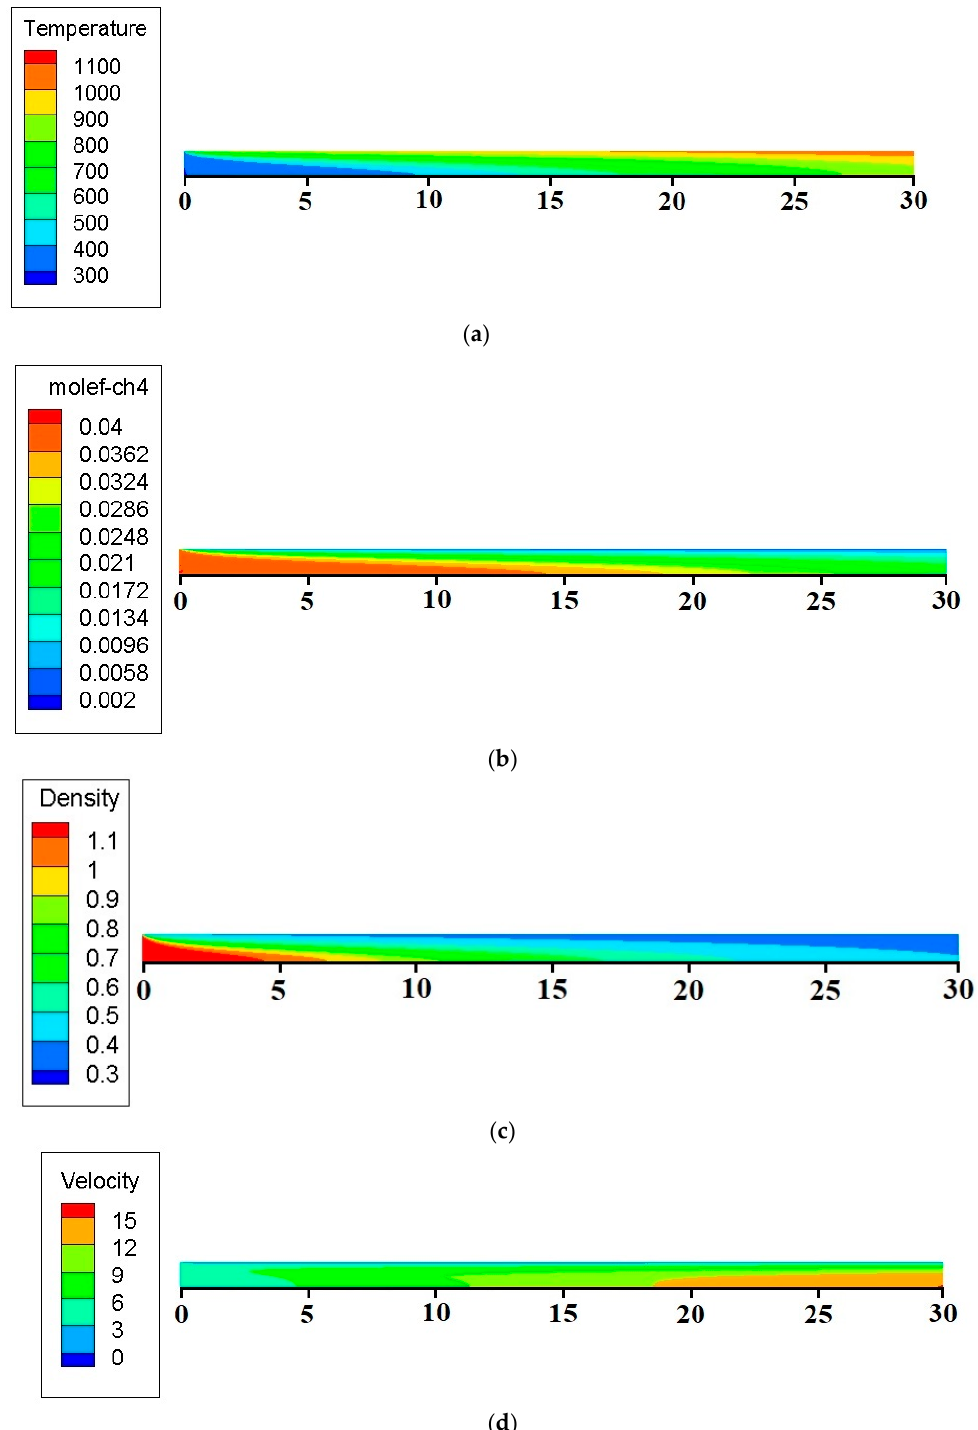
Figure 21. Temperature, concentration, density, and flow velocity distribution, 2 MPa, 4% of CH 4 . ( a ) Temperature distribution. ( b ) Methane concentration distribution. ( c ) Density distribution. ( d ) Velocity distribution.